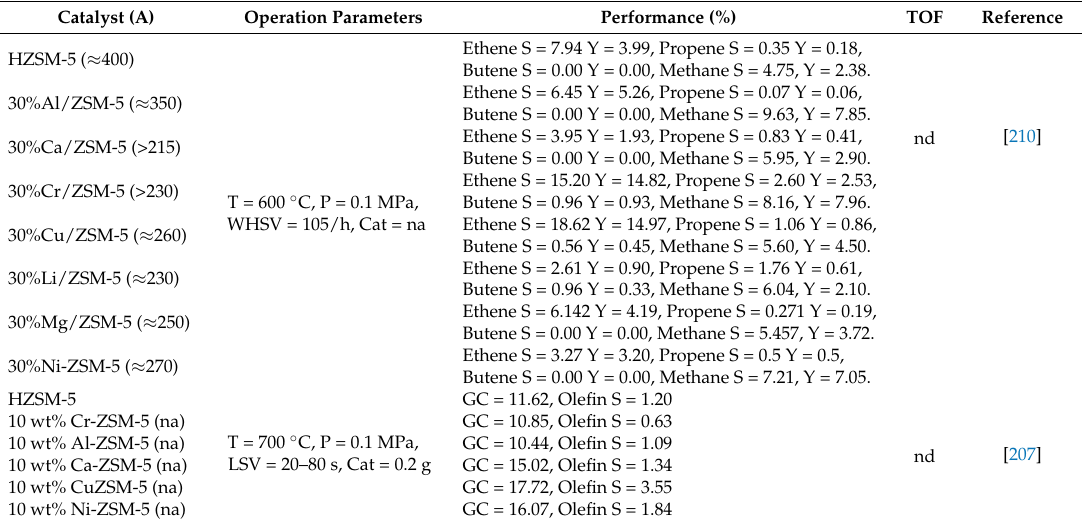
Table 15. Performance of some catalysts in the conversion of glycerol to olefins as reported in some literature. Catalyst (A) Operation